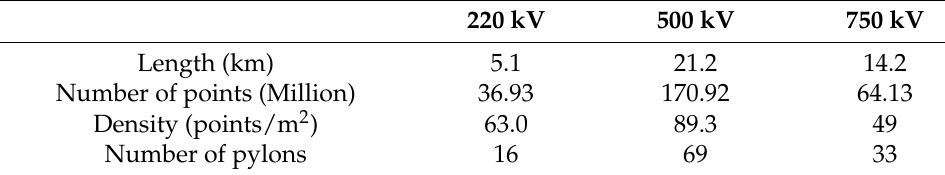
Table 1. The description of the three level